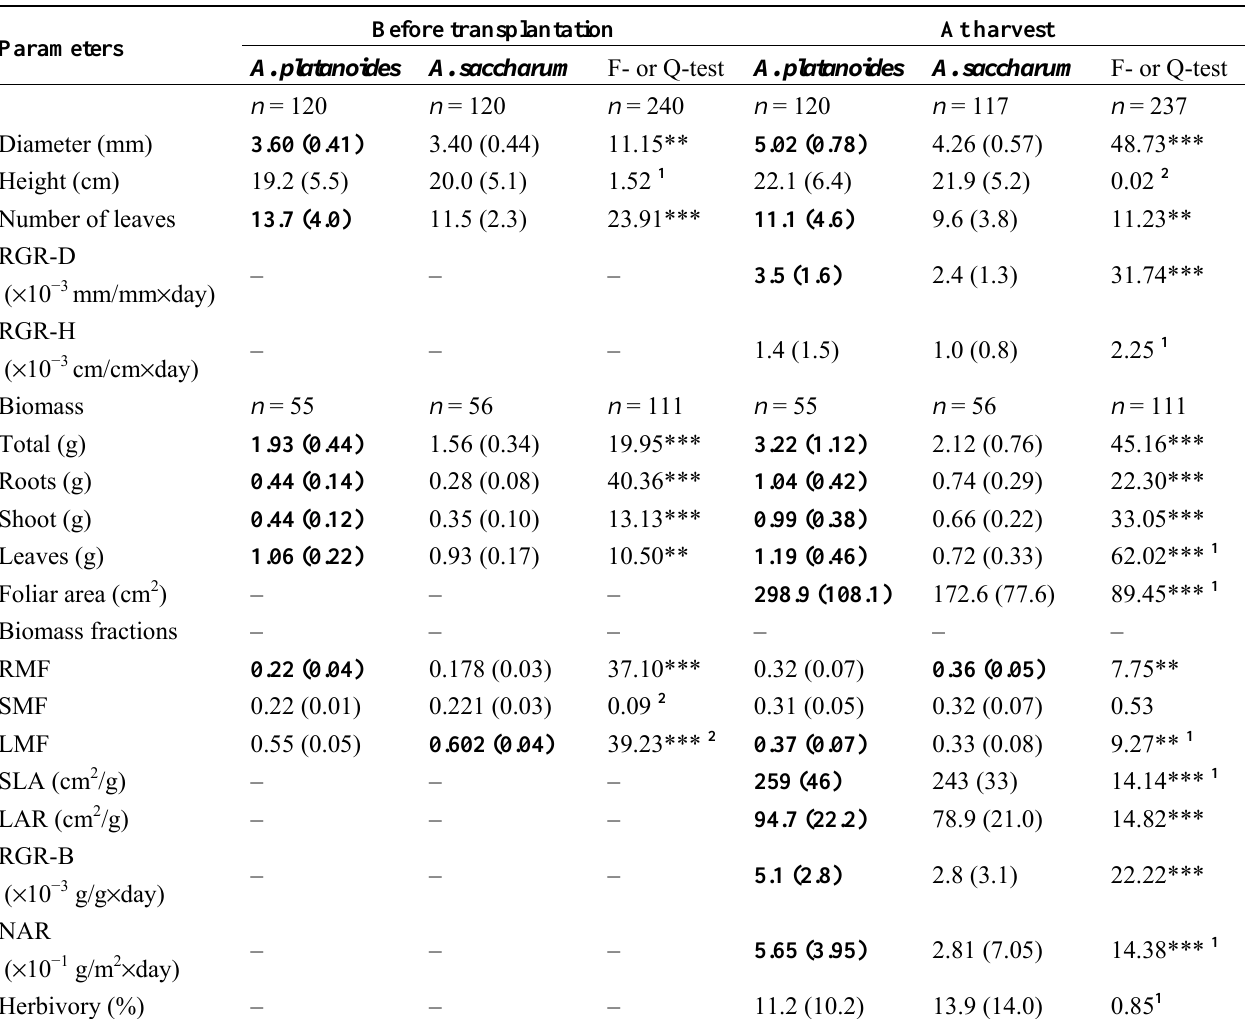
Table 2. Acer platanoides and A. saccharum seedling descriptive parameters before transplantation and at harvest. Mean values (± SD) are given for each variable, together with test-statistics ( P -values) for the species comparisons. Values in bold are significantly higher for a given